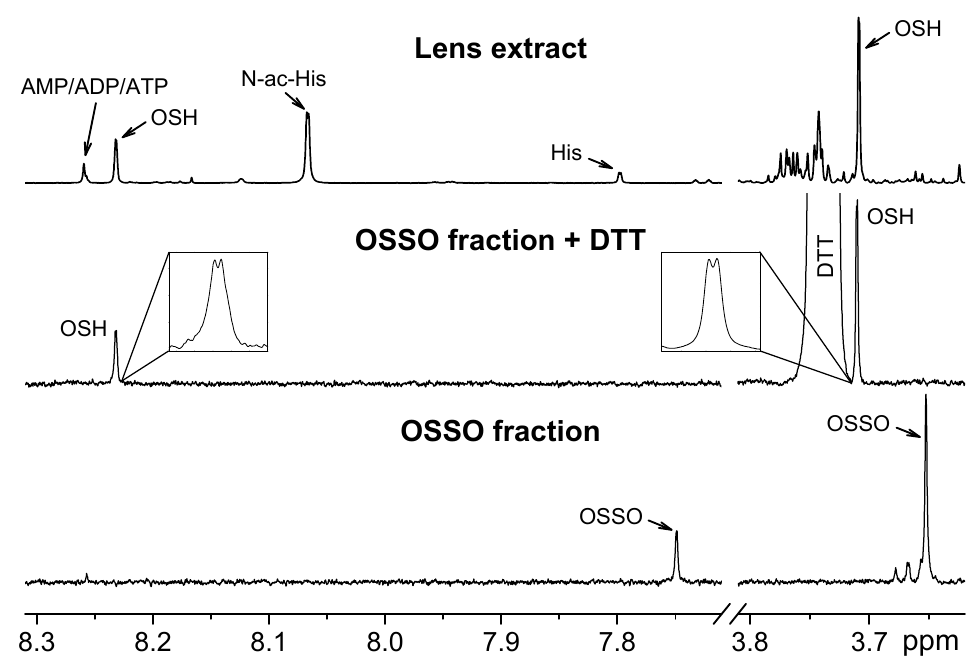
Figure 1. Selected regions of 1 H NMR spectra of the lens extract, OSH and OSSO. Upper graph: NMR spectrum of protein-free extract from S. lucioperca lens. Arrows show the signals from OSH, histidine (His), N-acetylhistidine (N-ac-His), and AMP/ADP/ATP. Lower graph: NMR spectrum of chromatographically separated ovothiol-containing fraction from the S. lucioperca lens extract. Middle graph: NMR spectrum of the same fraction with the addition of DTT; insets show the expanded regions of the spectrum demonstrating the signals from NCH 3 (3.707 ppm) and imidazole (8.228 ppm) protons of OSH. All spectra were recorded in deuterated buffer pH 7.2. Chemical shifts are given relatively to the internal standard DSS.